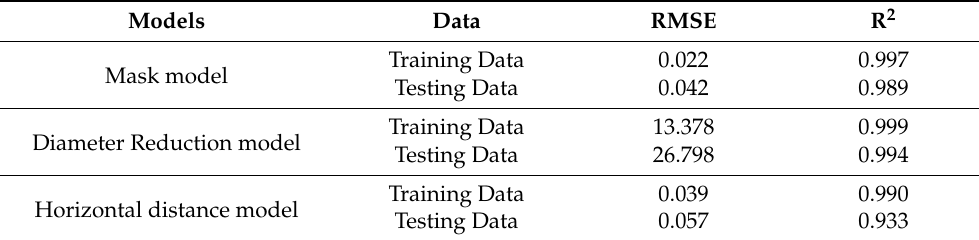
Table 2. The accuracies of the proposed methods.